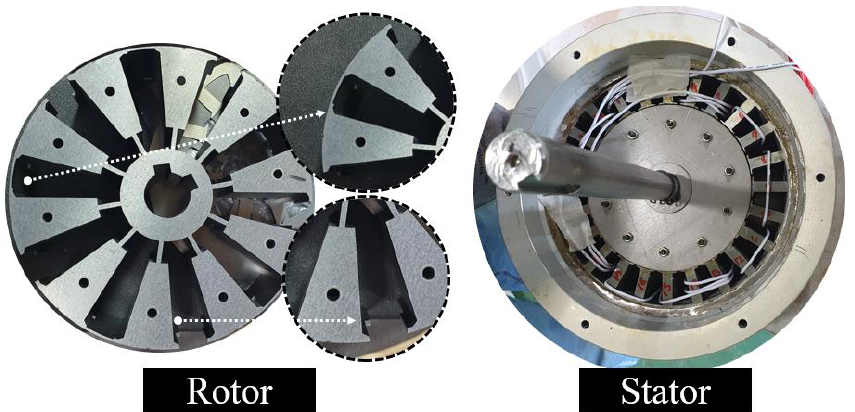
Figure 18. Image of the prototype generator core.